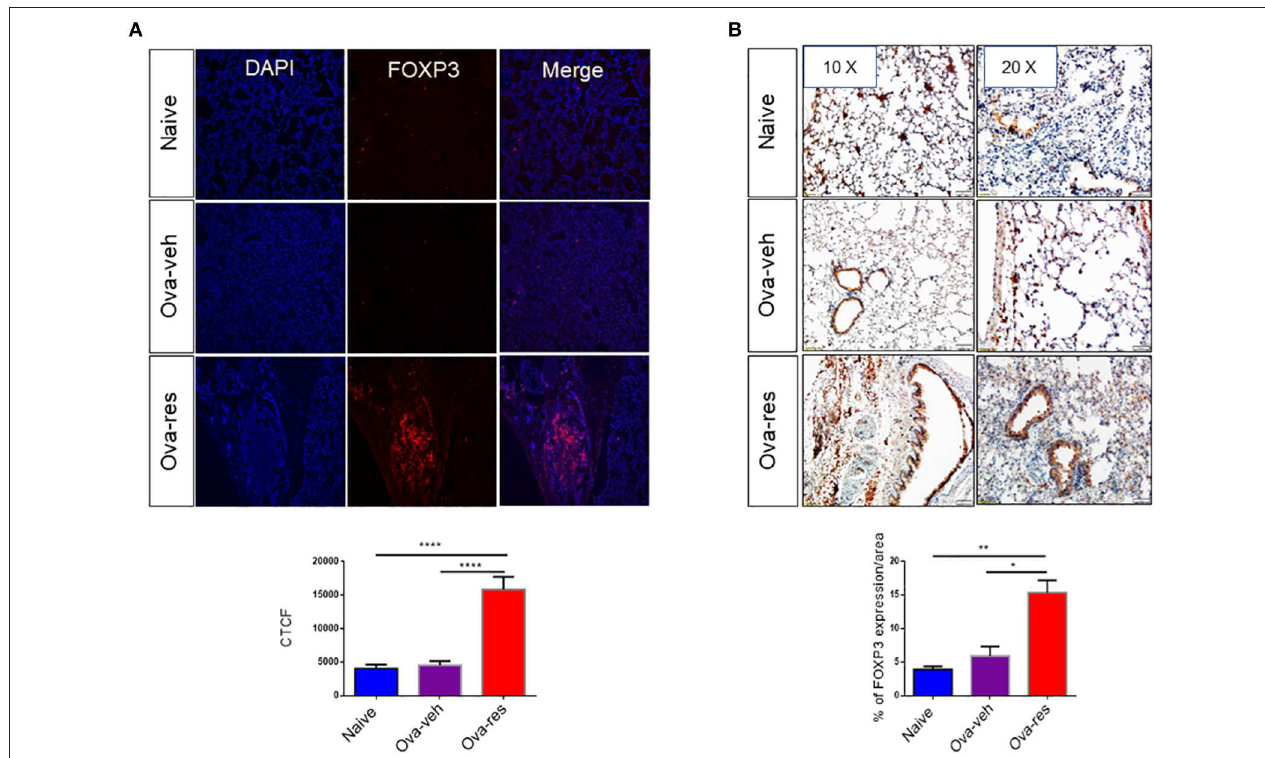
FIGURE 5 | Resveratrol treatment leads to induction of FOXP3 + cells in the lungs: Immunofluorescence and immunohistochemistry were performed to determine the expression of FOXP3 in lung tissues and FoxP3 expression in the cells was assessed using corrected total cell fluorescence (CTCF) and ImageJ software. (A) Shows the expression of FOXP3 in lung tissues. The data in vertical bars represent Mean + /– SEM of 10 random spots analyzed. Significance (* p < 0.05) of FoxP3 expression between the groups was analyzed using Student’s t -test. (B) Shows FoxP3 expression in lung tissues by performing immunohistochemistry. The data represented as Mean + /– SEM of random 3–5 spots that were analyzed. The number of mice used (Naïve: n = 3, OVA-veh: n = 3, and OVA-res: n = 3). Significance (** p < 0.01, **** p < 0.0001) in FoxP3 expression was detected using one-way ANOVA and post-hoc Tukey’s